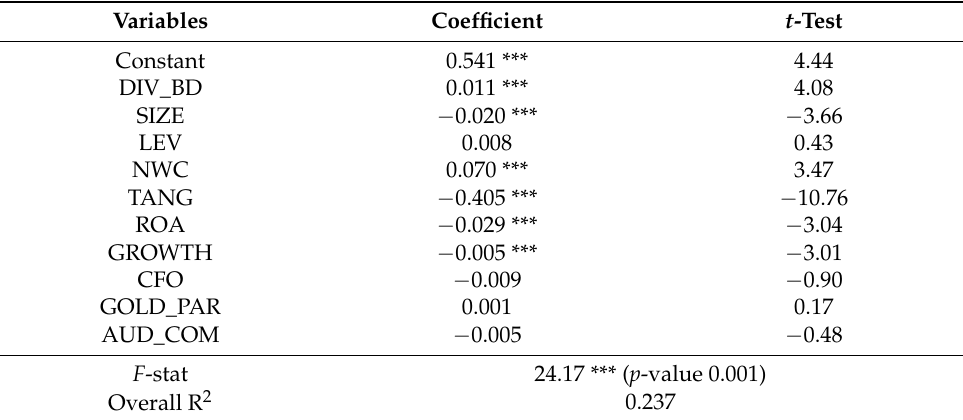
Table 10. Board gender diversity and excess cash